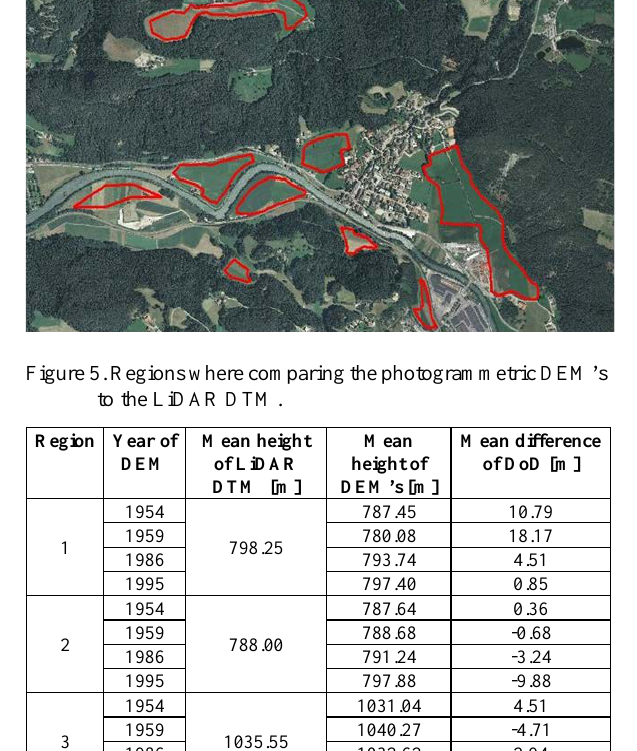
Figure 6. Classification of buildings depending on the period of construction, as well as other areas that might have been interested by relevant geological processes.